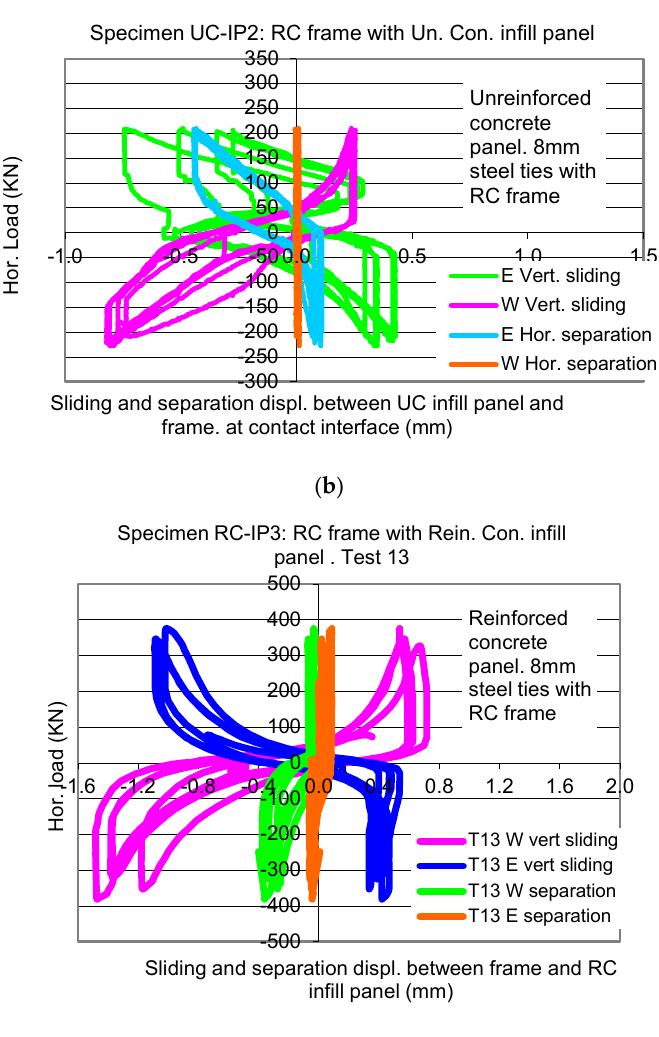
Figure 15. ( a ) Horizontal load cyclic response versus sliding at the contact surface of the concrete infill panel and surrounding frame for specimen UC-IP 1. ( b ) Horizontal load cyclic response versus sliding or separation at the contact surface of the concrete infill panel and surrounding frame for specimen UC-IP 2. ( c ). Horizontal load cyclic response versus sliding or separation at the contact surface of the concrete infill panel and surrounding frame for specimen UC-IP 3.